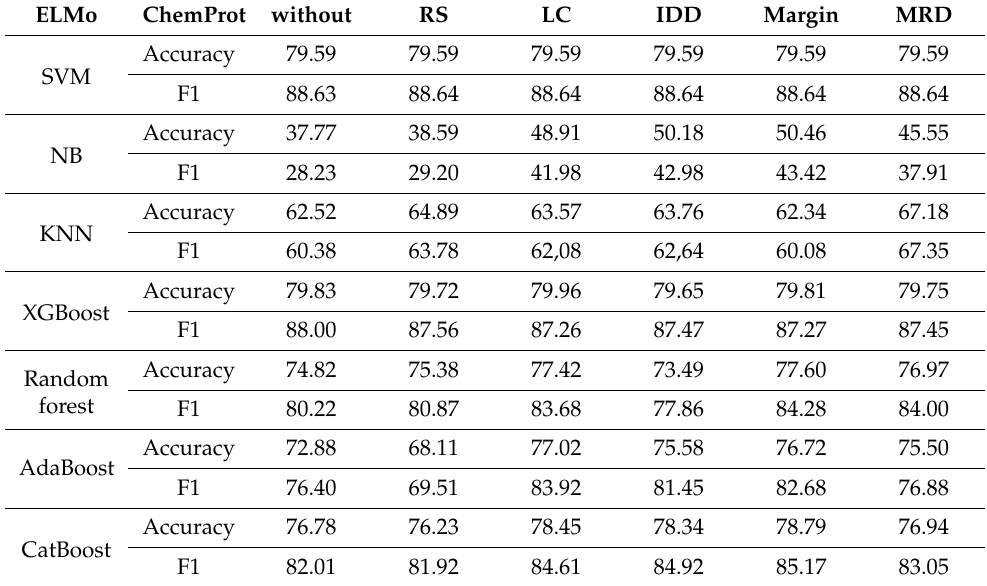
Table 13. Comparison of results with and without AL methods (ELMo) for ChemProt